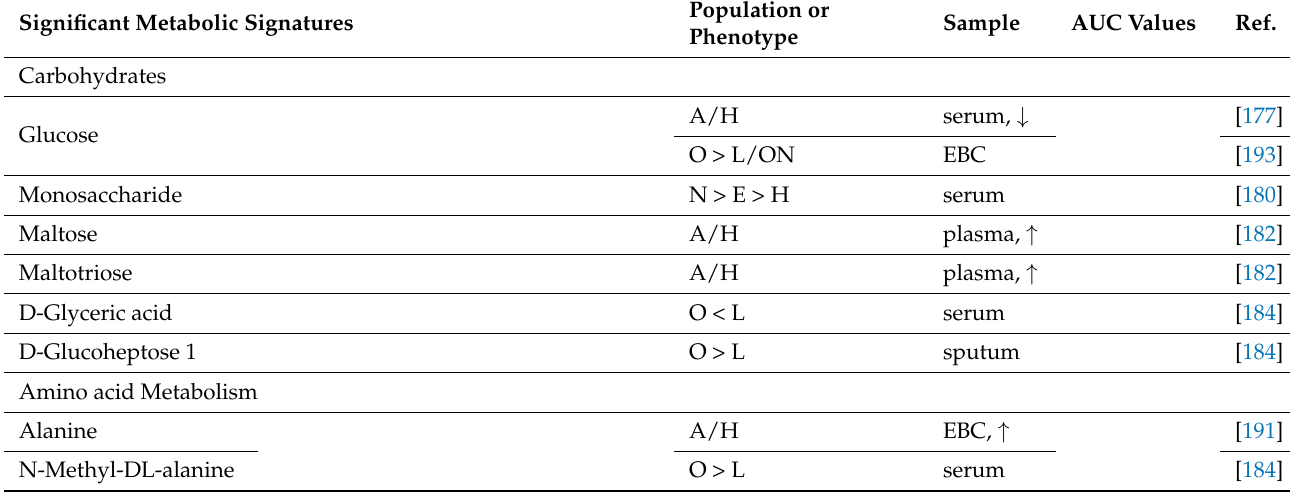
Table 5. Metabolic signatures for asthma and its